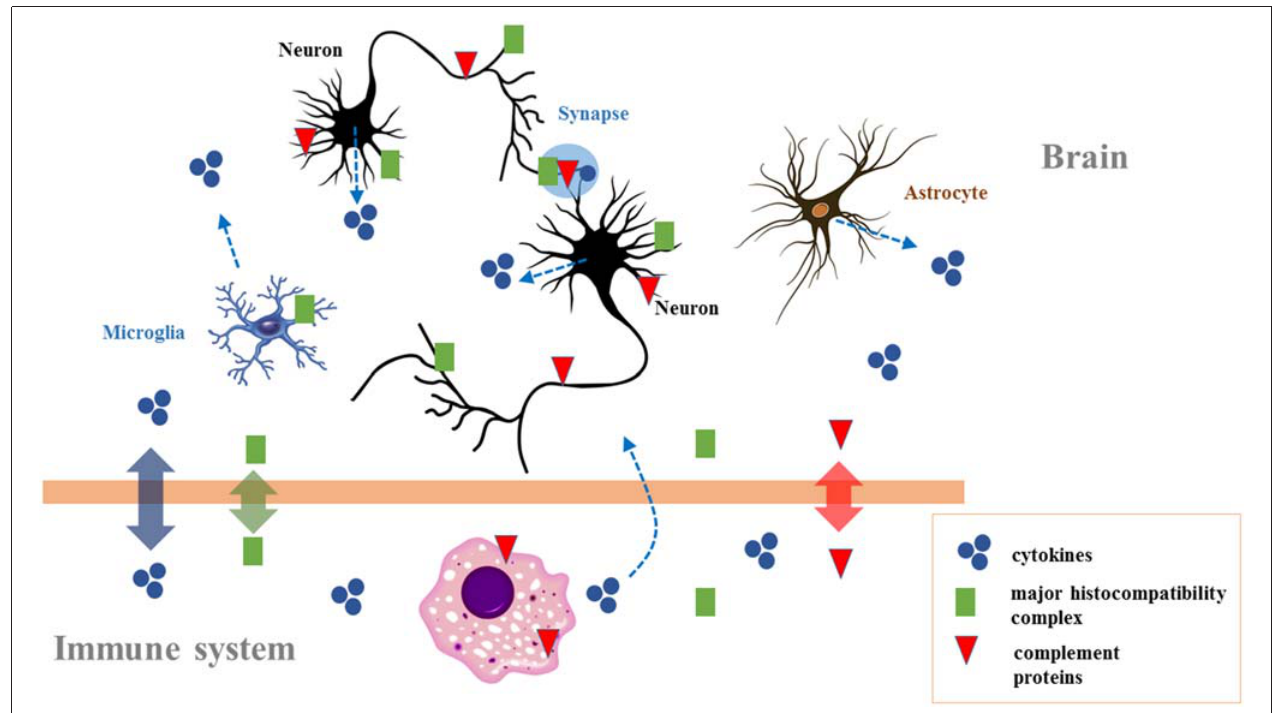
FIGURE 2 | The crosstalk between the immune system and the brain. Immune molecules cross the blood–brain barrier on occasion of brain damage. They are also expressed during brain development, affecting neurogenesis, neuronal migration, axon guidance, and synapse formation. In the adult brain they modulate activity-dependent refinement of neural circuits and synaptic plasticity (including long-term potentiation, long-term depression, and synaptic scaling), as well as brain function (including cognition). Because chronic changes in the immune molecules levels are observed in neurodevelopmental disorders (particularly autism and schizophrenia), they could also contribute to the neurocognitive profile of affected individuals. Adapted from Garay and McAllister (2010; Figure